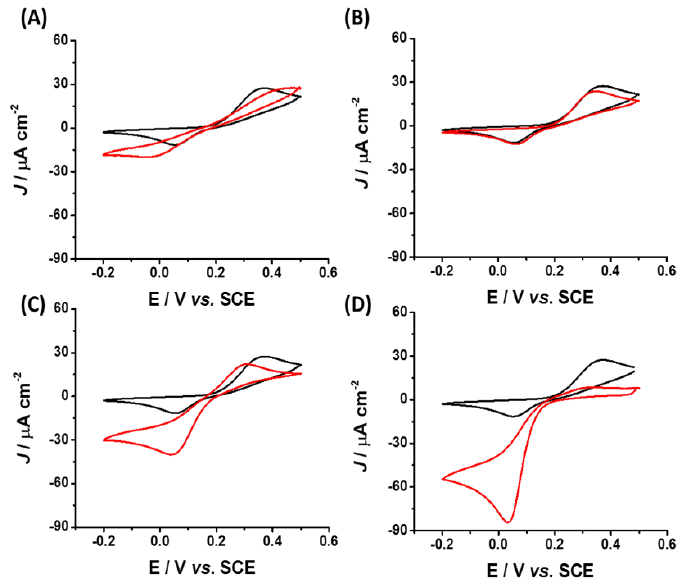
Figure 6. Cyclic voltammograms of OL nanocapsules (black line, A – D ), Catalyst I (red line, ( A )), Catalyst II (red line, ( B )), Catalyst III (red line, ( C )), and Catalyst IV (red line, ( D )) performed in 250 µ